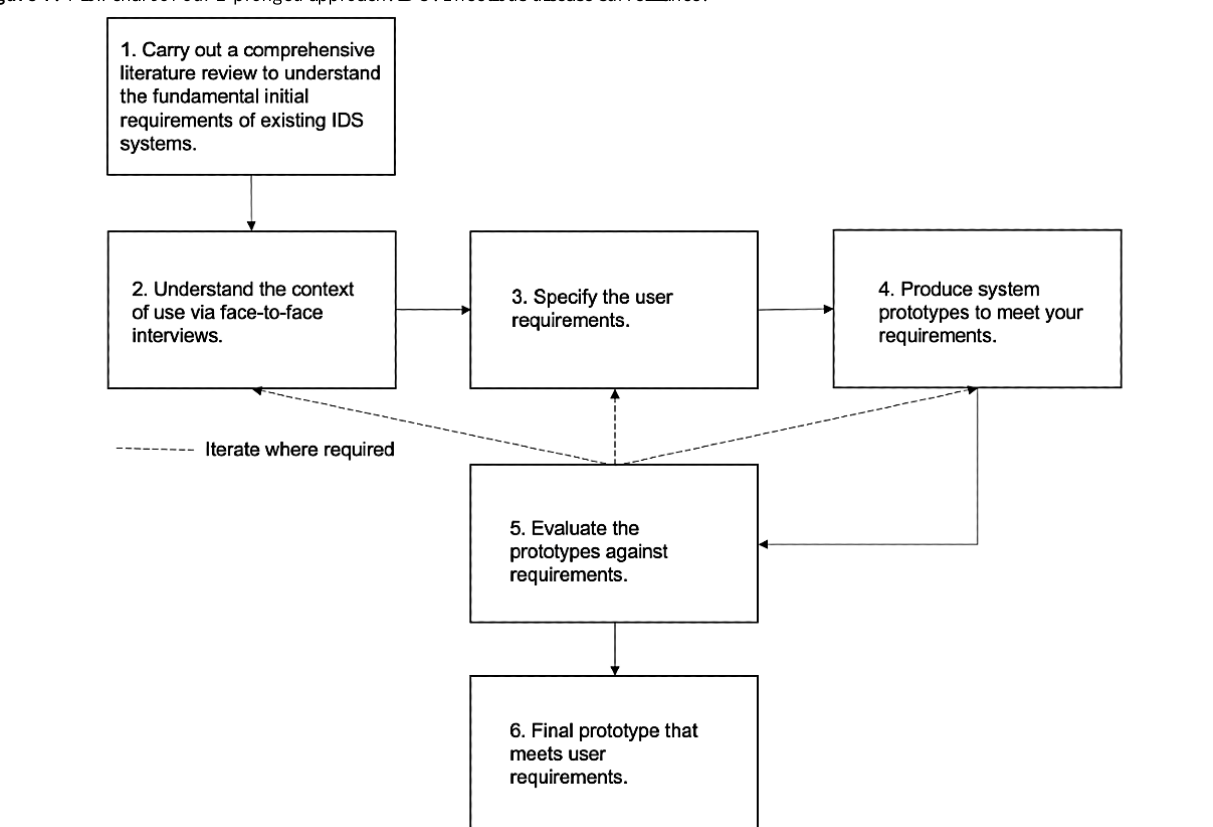
Figure 1. Flowchart of our 2-pronged approach. IDS: infectious disease